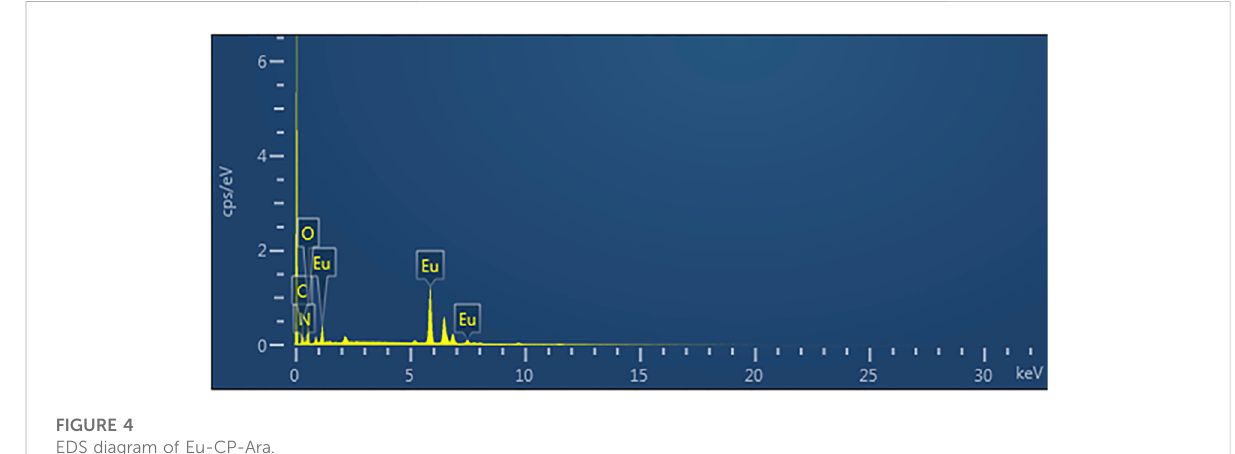
FIGURE 4 EDS diagram of